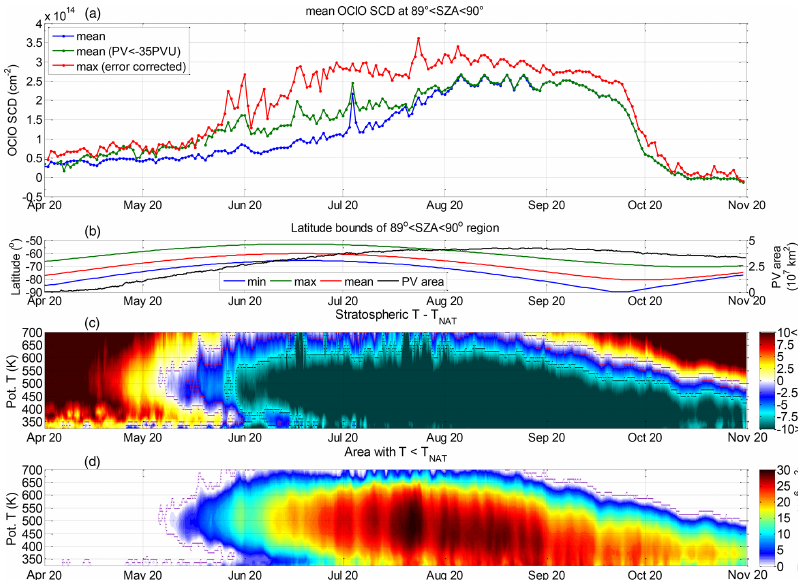
Figure 16. Same as Fig. 1 but for the Antarctic winter 2020.